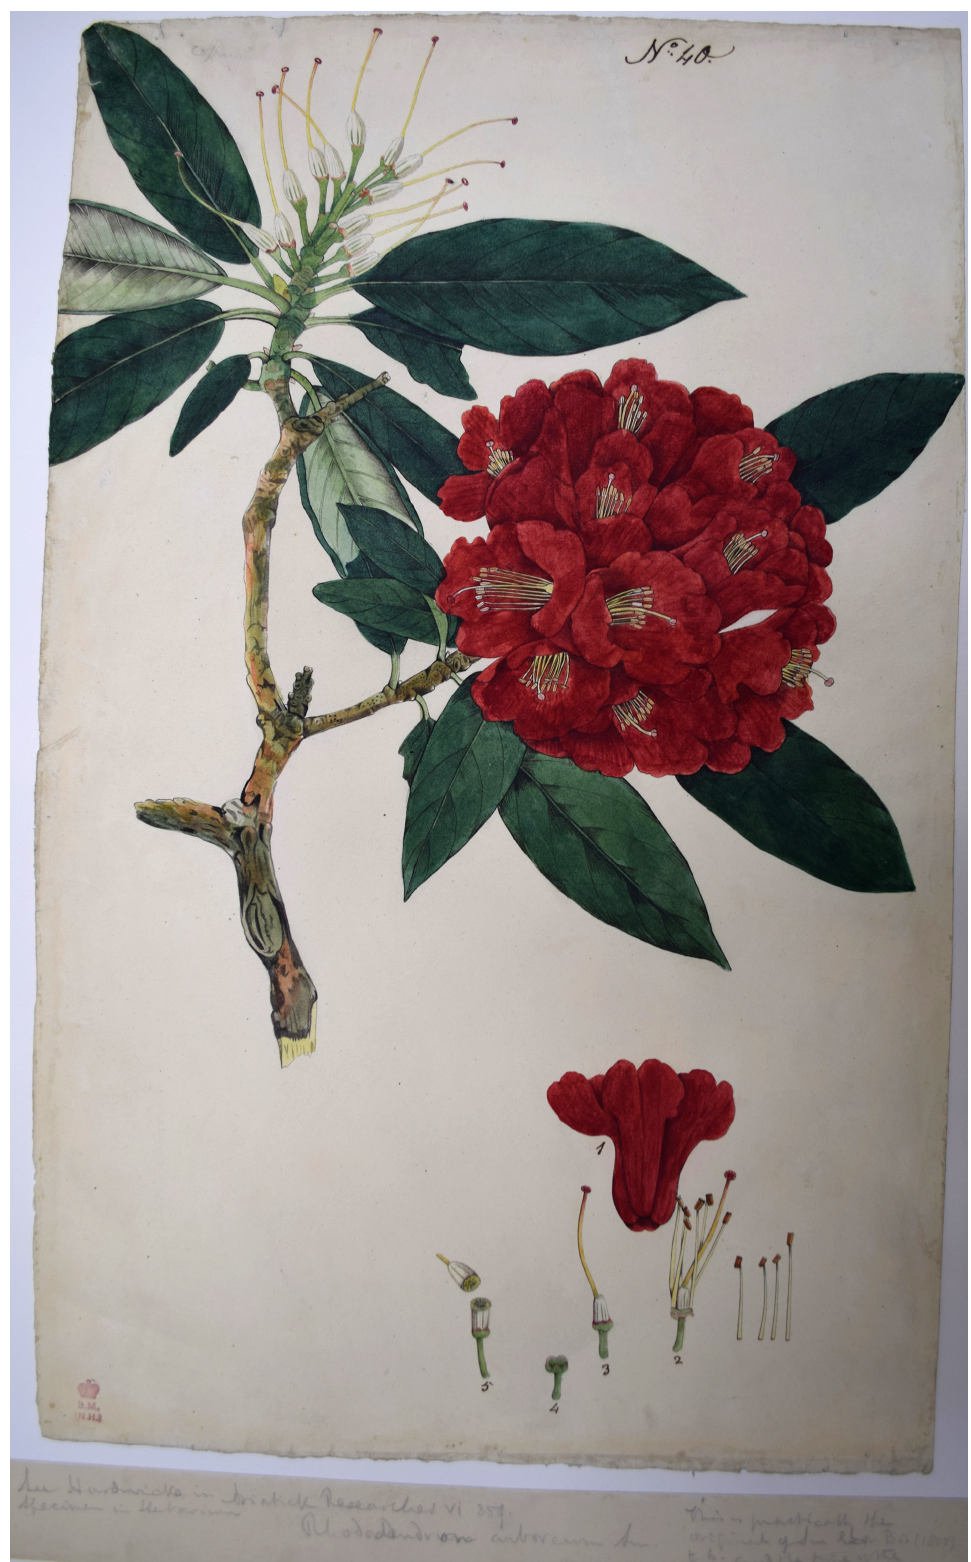
Fig. 6. Lectotype of Rhododendron arboreum Sm., Hardwicke Drawing no. 40 from the collection of the Botany Library, Natural History Museum. © The Natural History Museum,